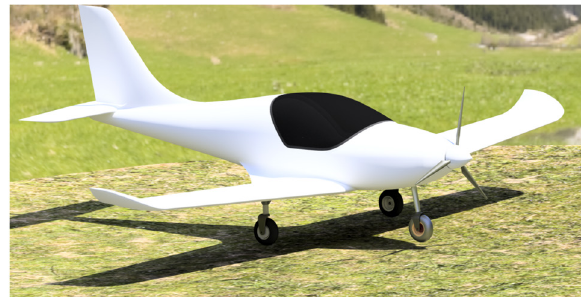
Figure 1. 600 kg ultralight, light sport aircraft with retractable undercarriage